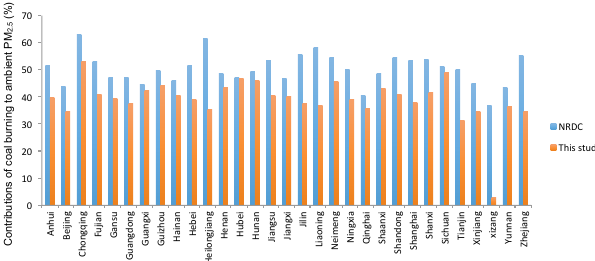
Figure 9. Comparison of coal contribution to PM 2 . 5 concentration between NRDC and this